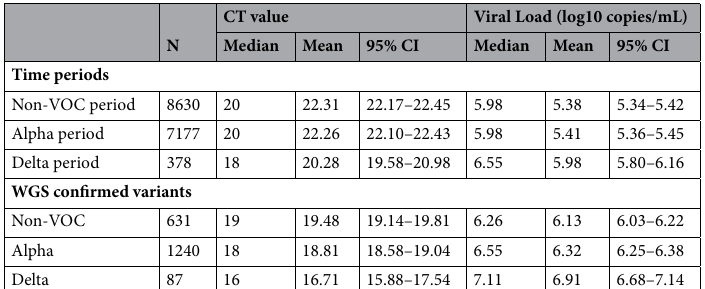
Table 1. comparison of CT values and viral loads between non-VOC, Alpha and Delta variants of SARS- CoV-2.